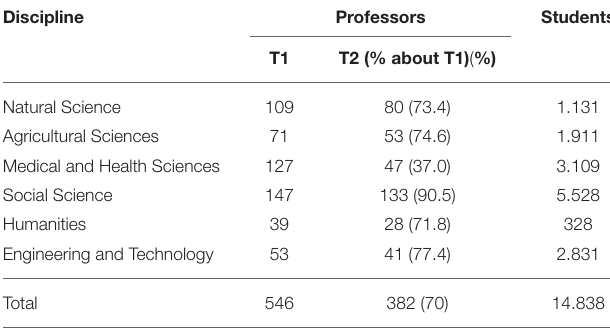
TABLE 1 | Description of participating professors and